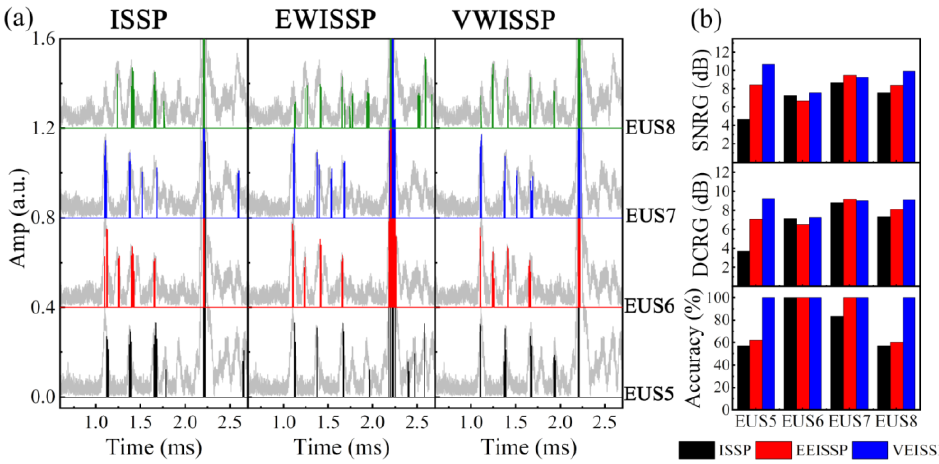
Figure 20. ISSP, EWISSP, and VWISSP processing results of EUS 5 to